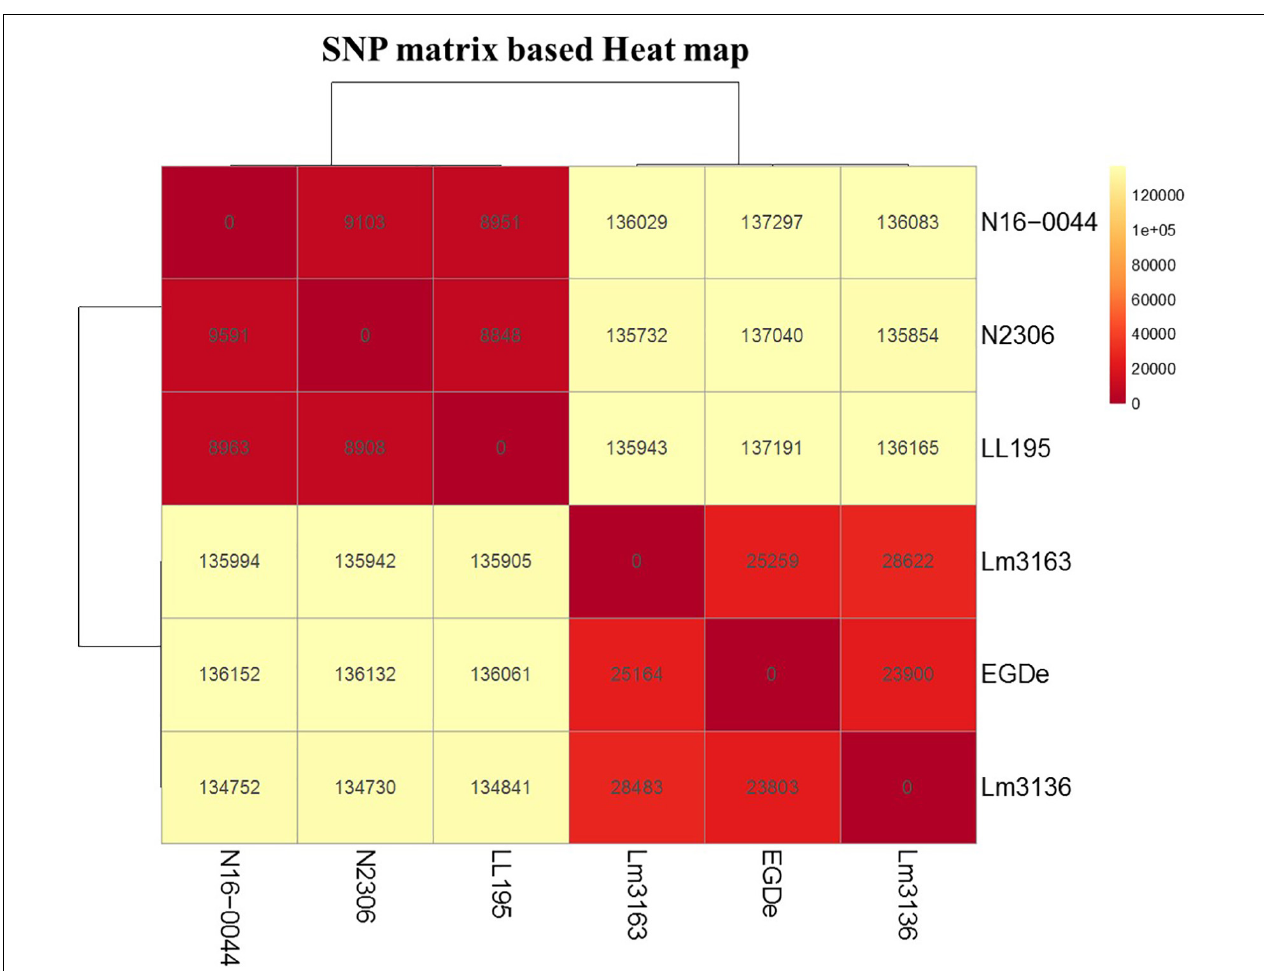
strains including lineage specific distribution of some